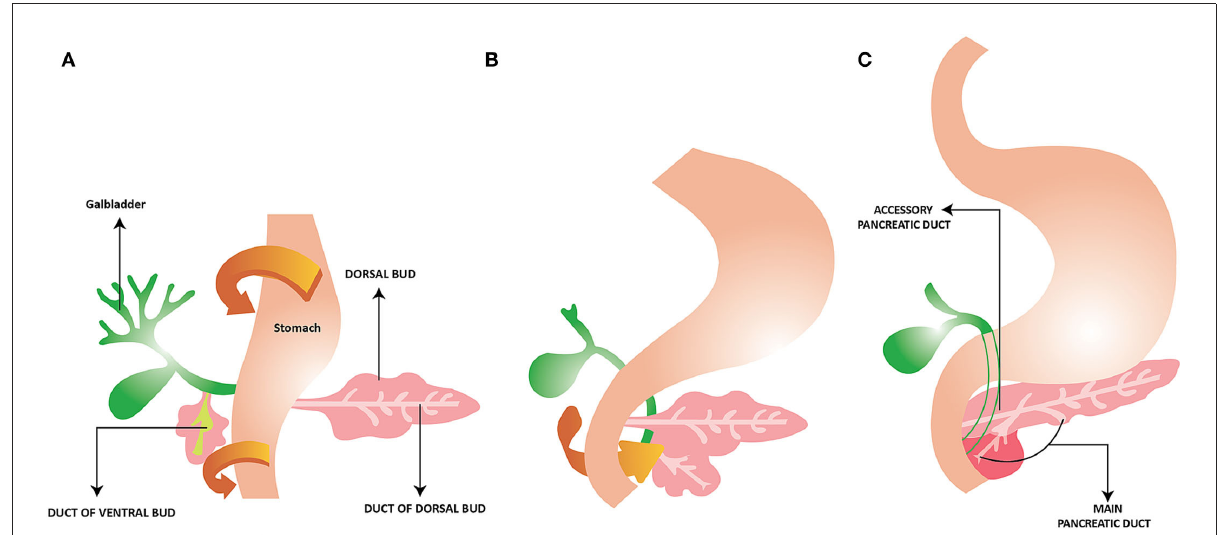
FIGURE1 Development of the Pancreas. (A) Rotation of the ventral bud with the stomach and duodenum to the right. (B) The ventral and dorsal bud fuse together. (C) The main pancreatic duct exiting via the ventral bud to the duodenum. Ventral bud gives rise to uncinate process and part of the head of the pancreas. The dorsal bud gives rise to the remainder of the pancreas. Reprinted from “Pancreatic Duct Variations and the Risk of Post-Endoscopic Retrograde Cholangiopancreatography Pancreatitis” Ojo A S. Cureus, 12 (9): e10445. 2020 by